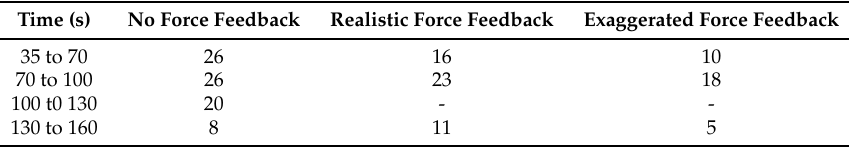
Table 8. Settling time, s ( t s ) at different time